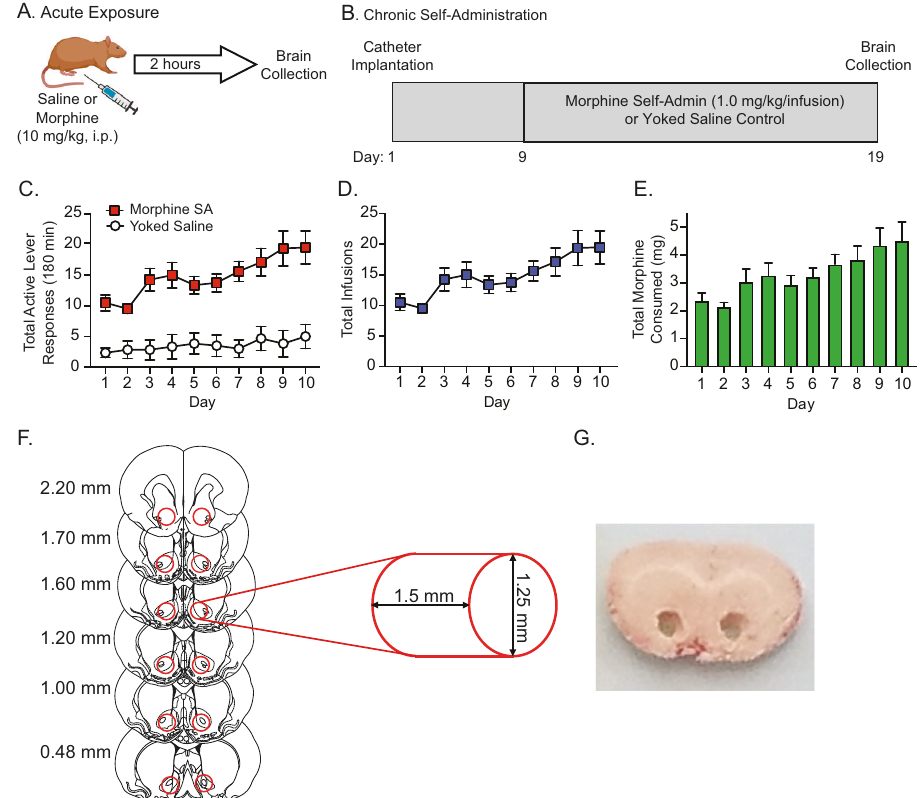
Fig. 1 Morphine treatment. Male Brown Norway rats were randomly assigned to the single experimenter-delivered experiment ( A ) or the chronic self-administration (Self-Admin) experiment ( B ). In the acute exposure experiment, rats received a single injection of morphine or saline ( n = 5 each). In the chronic self-administration experiment, animals were allowed to self-administer morphine in daily test sessions or received yoked saline infusions ( n = 6 each). The total number of active lever presses ( C ), total number of morphine infusions per day ( D ), and the total morphine infused per day ( E ). Following morphine and saline treatments, brains were frozen and the nucleus accumbens ( F ) was punched from coronal sections ( G